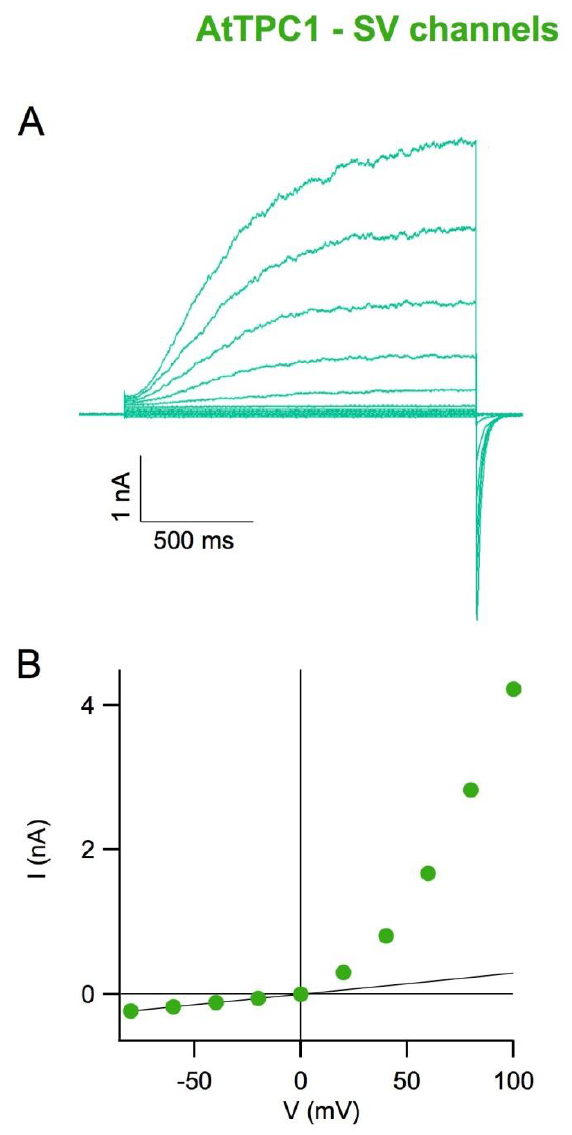
Figure 1. Slow Vacuolar channels in plant vacuoles. ( A ) AtTPC1–SV currents recorded in a vacuole isolated from Arabidopsis mesophyll cells in excised cytosolic side-out patch configuration. Currents were elicited by a series of voltage steps ranging from − 80 mV to +100, in 20 mV steps. Holding potential − 50 mV, tail potential − 50 mV. Pipette solution (in mM); 200 KCl, 2 MgCl 2 , 2 CaCl 2 , 10 MES/Tris, pH 5.5; bath solution (in mM): 100 KCl, 2 MgCl 2 , 1 CaCl 2 , 1 mM dithiothreitol (DTT), and 10 mM HEPES/Tris, pH 7.5. The osmolarity in both solutions was adjusted to 600 mOsm by the addition of D-sorbitol. ( B ) SV current – voltage characteristics of the traces shown in panel A. The I–V characteristics are constructed by plotting the average value of the currents recorded during the last 50 ms at each applied voltage. Positive currents represent cations entering the vacuole. The continuous black line represents the background current evaluated from the linear fitting of the current between − 80 and 0 mV.